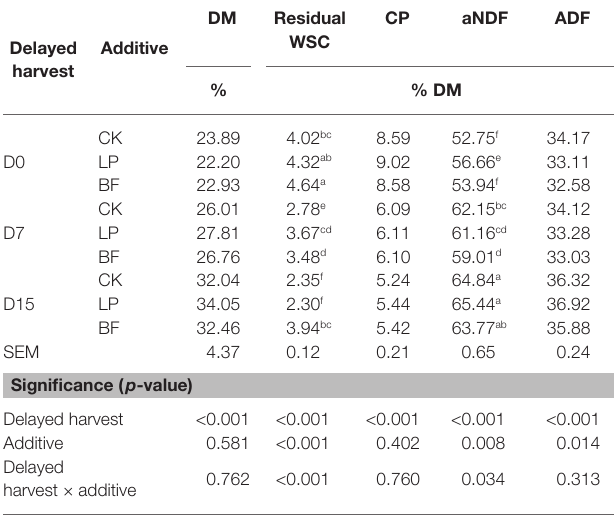
TABLE 2 | Chemical composition of corn stalk silages treated without (CK) or with Lactobacillus plantarum (LP) and sodium benzoate (BF).